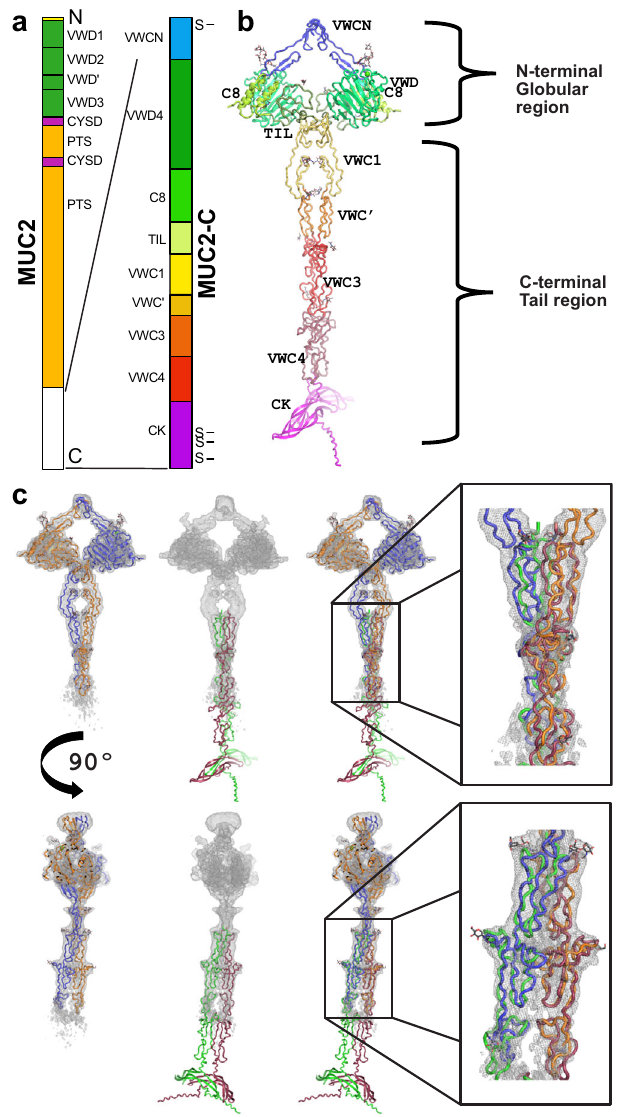
Fig. 1 | MUC2-C structural model. a The domain organization of the complete humanMUC2mucinandtheexpressedMUC2-C. b Coloredcartoonrepresentation of the full structure of MUC2-C assembled as a dimer. The different domains are colored as in a . c Frontal and lateral views of the combined Cryo-EM and Alpha- Fold2modelsofMUC2-C.Ther.m.s.d.ofthesuperpositionoftheAlphafold2model andtheCryo-EMmodelis3.5and3.7foreachmonomer.Ther.m.s.d.deviationwas calculatedconsidering the C α fromthe VWC ’ tothe VWC3.In orangeand blue, the two different monomers of the MUC2 C-terminal modelobtainedbyCryo-EM.The Cryo-EM map is represented as a grey net. In green and red the two different monomers of MUC2 C-terminal model obtained by